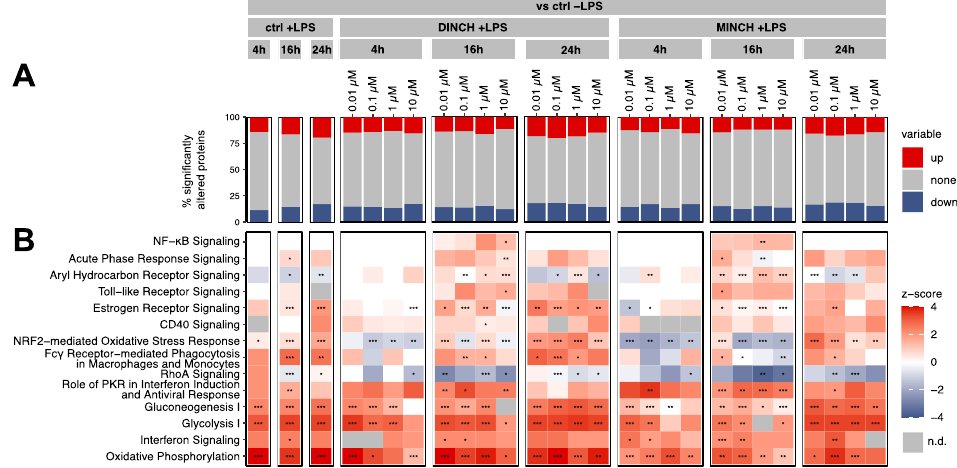
Figure 2. Proteomics analysis of DINCH and MINCH in THP-1 M1-like macrophages using Log2(FCs) of treatment vs. unstimulated control (ctrl – LPS). Differentiated THP-1 cells were treated with increasing concentrations of DINCH and MINCH for 4, 16, and 24 h. Fold changes (FCs) of the treatments to the unstimulated control ( – LPS) containing an equivalent amount of MeOH were calculated. ( A ) Percentage of significantly ( p ≤ 0.05, n = 4) altered proteins which were subjected to Ingenuity Pathway Analysis (IPA). ( B ) Heatmap of selected significantly (adjusted p ≤ 0.05) enriched pathways in treated THP-1 cells. The heatmap is colored based on z-scores calculated by IPA, indicating the direction of pathway regulation (z-score > 0 pathway is up-regulated, z-score < 0 pathway is down-regulated, not detected is marked in grey). Significant changes are labeled with asterisks (* p ≤ 0.05, ** p ≤ 0.01, *** p ≤ 0.001, n = 4).